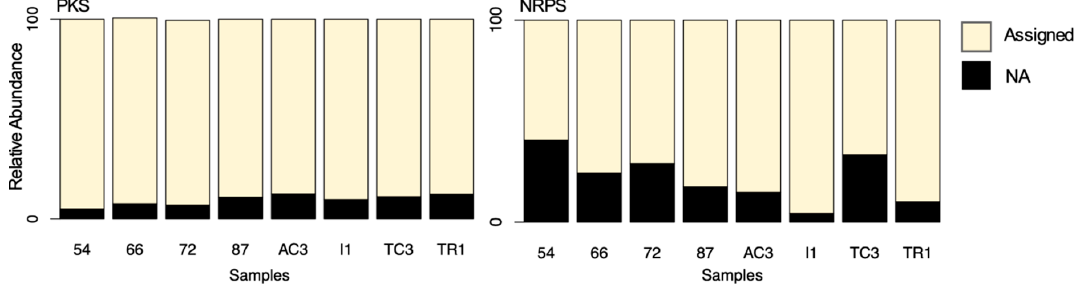
Figure 7. Distribution of assigned versus not-assigned polyketide synthase (PKS) and non-ribosomal peptide synthetase (NRPS) sequences by blast to the MiBiG database.